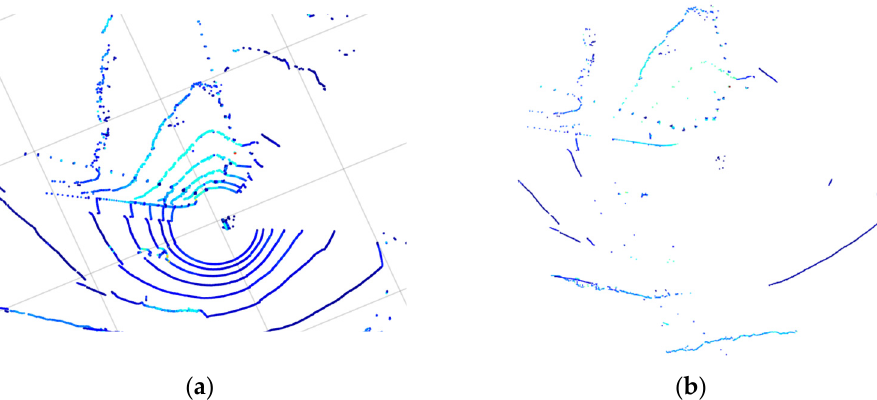
Figure 17. Scan frame at epoch 40,647 s with big outlier in Trajectory Section 1 around the roundabout (( a ) the original scan view; ( b ) the view after pre-processing).